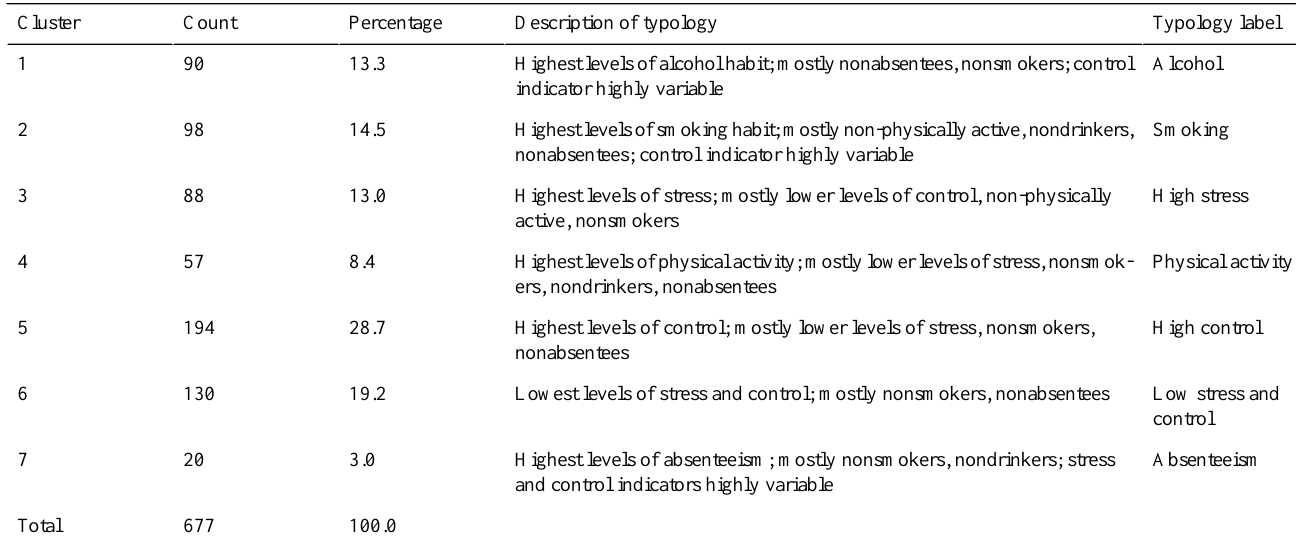
and control indicators highly